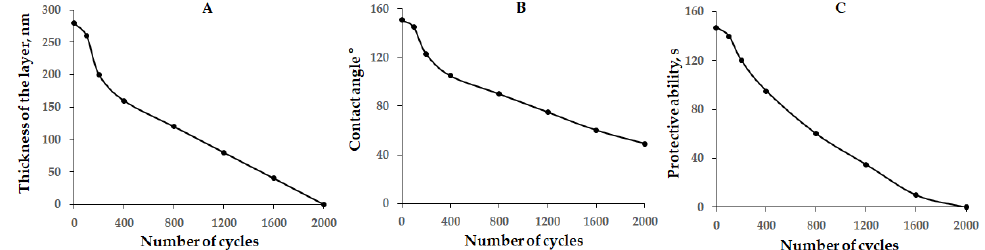
Figure 9. Dependence of the thickness of the stearate coating ( A ), contact angle ( B ), and protective ability ( C ) on the number of abrasion cycles.